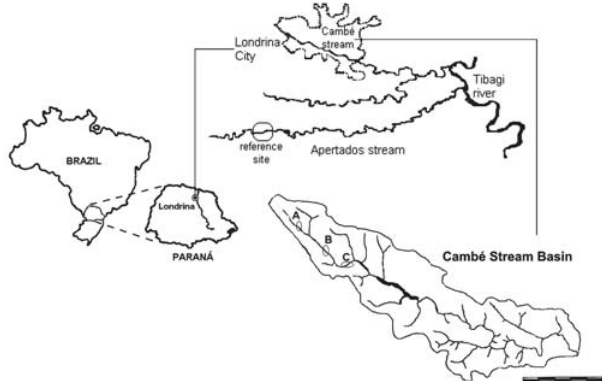
Fig. 1. Map showing the region of Londrina city (Paraná State), where the in situ tests were carried out at the reference site (Apertados stream), and the sites at Cambé stream (A, B and